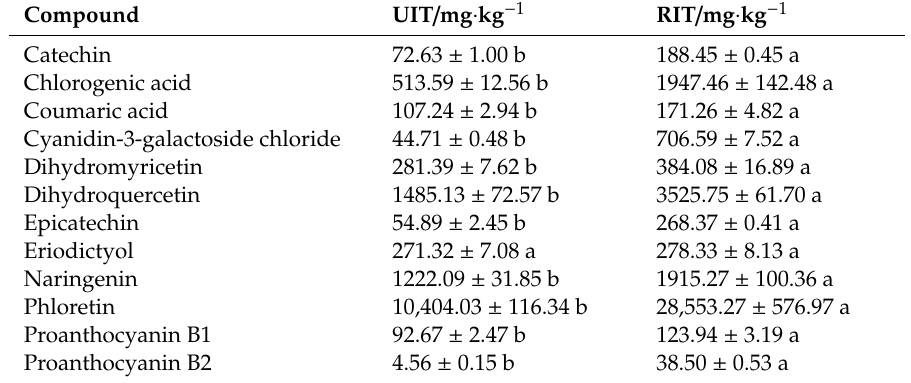
Table 1. Type and content of anthocyanin biosynthesis-related compounds in UIT and RIT samples.